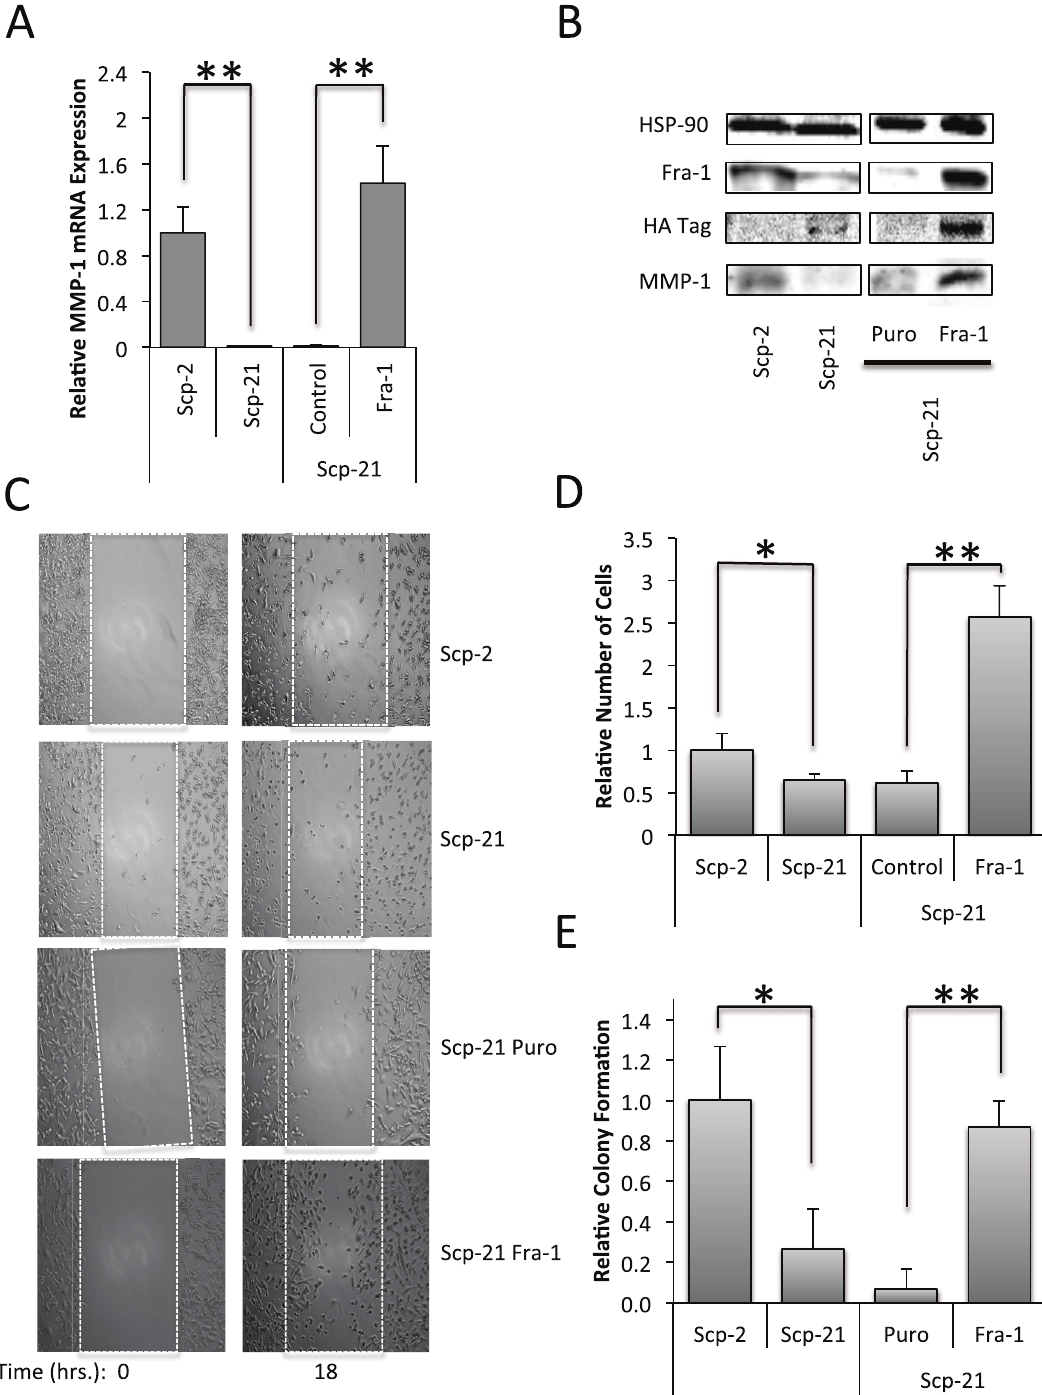
Figure 8. Effects of Fra-1 over expression in Scp-21 cells. A ) qPCR of MMP-1 in Scp-2, Scp-21, Scp-21 control vector (Puro), and Scp-21 cells stably expressing HA-tagged Fra-1. Mean relative values are +/- standard deviation from three independent experiments. B ) Immunoblots of the indicated cell lines with anti-MMP-1, anti-Fra-1 and anti-HA antibodies. Anti-HSP-90 served as a loading control. C ) Effect on cell motility. Scratch-wound assays of the indicated cell lines were performed with cell motility measured 0 and 18 hours after the scratch. Cells were grown to 95% confluency and scratched with a pipette tip. Images were taken at 100X magnification. D ) Quantitation of the number of cells crossing the initial scratch threshold at 18 hours. The means of three fields in three independent experiments +/- standard deviation are shown. E ) Anchorage independent growth. The indicated cell lines were grown in soft agar for 21 days. The means +/- standard deviation of the relative number of colonies formed in three independent experiments are shown. *, p < 0.05. **, p < 0.005 for two-tailed